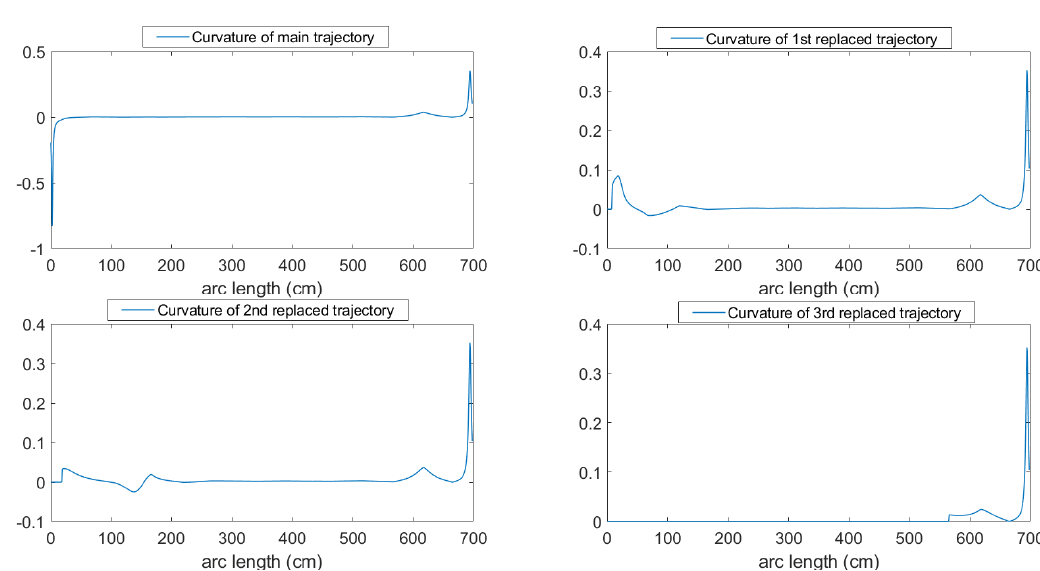
Figure 20. Trajectory curvature of the second scenario .